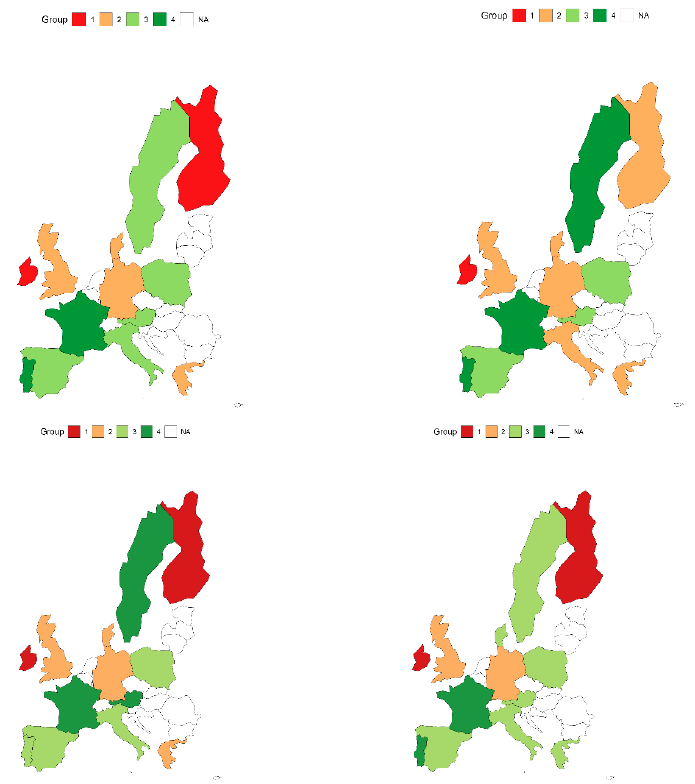
Figure 6. SISED for individual EU countries in 2007–2010.